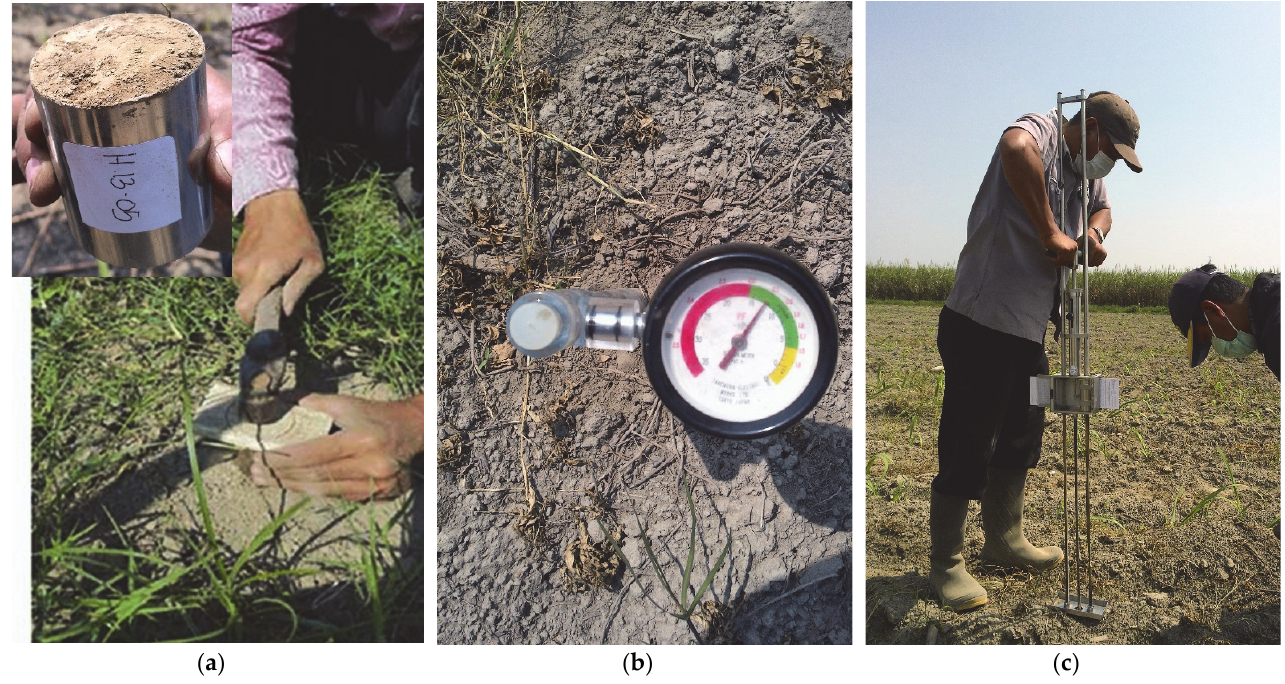
Figure 4. Soil sampling preparation and measurement: ( a ) Taking the sample for soil water content lab ‐ analysis; ( b ) Soil matric suction measurement; ( c ) soil penetration resistance measurement.